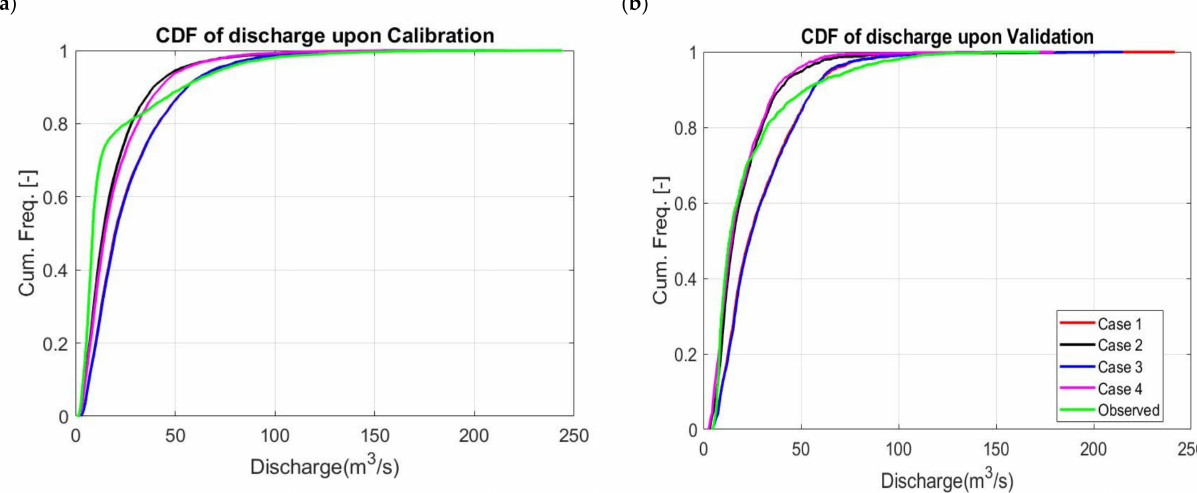
Figure A2. Cumulative distribution function of observed and simulated daily discharge ( a ) calibration ( b )